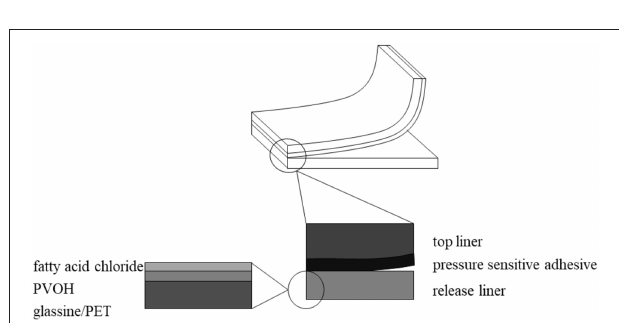
FIGURE 2 | Schematic representation of a structure showing top liner, pressure sensitive adhesive, and a release liner. The zoom in on the left shows the structure of the release liner varying in substrate type, PVOH type and fatty acid chloride chain